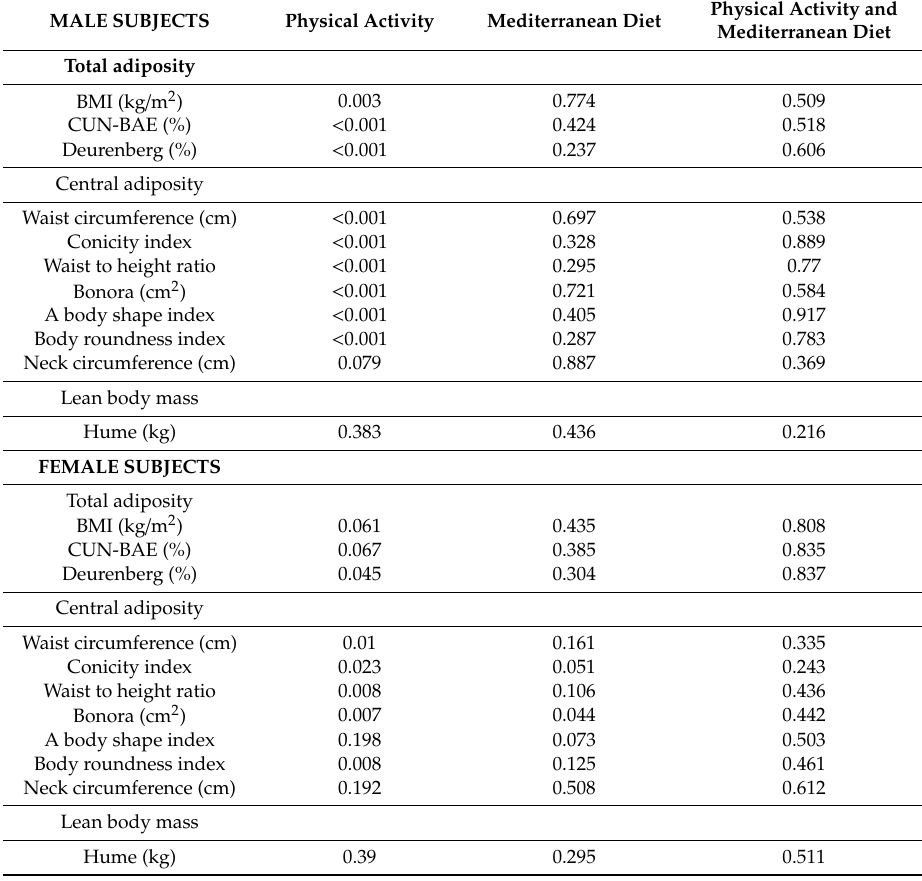
Table 5. Disjoin and join e ff ects of physical activity and the Mediterranean diet in obesity indices according to